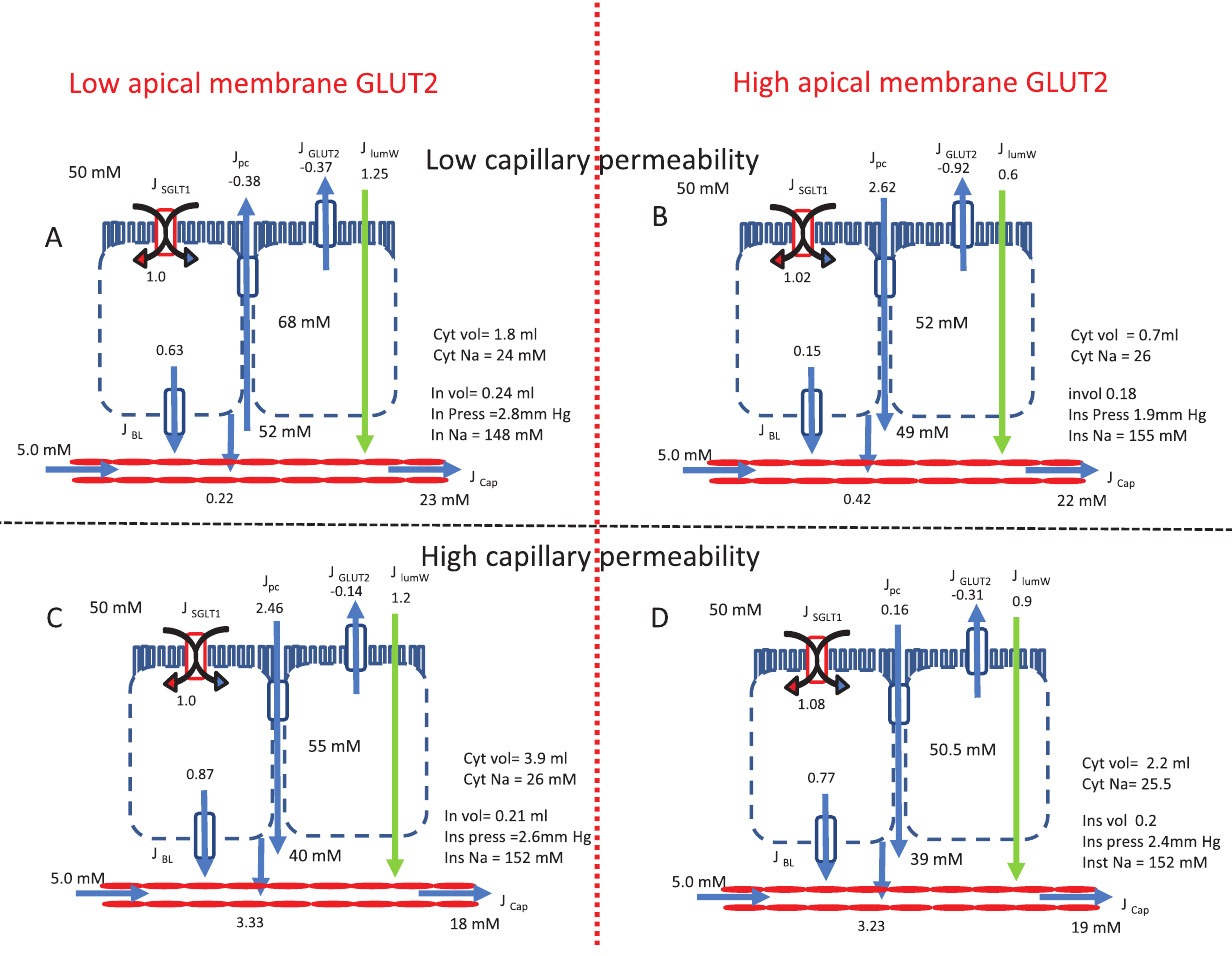
Figure 1. These diagrams show snapshots of the simulated glucose flows from intestinal lumen loaded with 50 mM in 150 mM NaCl to capillaries perfusing the submucosal spaces, whose afferent arterial concentration contains 150 mM NaCl and 5 mM D glucose. The tissue in panel A has low apical GLUT2 and GLUT5 activity and low capillary permeability and perfusion rates (clearance). In panel B the tissue apical membrane GLUT2 activity is increased by 4-fold above that in panel A , capillary perfusion is unchanged. In panel C , the apical GLUT2 activity is the same as in panel A , but capillary clearance is increased by 10-fold. In panel D , the apical GLUT2 is raised, as in panel B and the capillary clearance raised, as in panel C . The rates of glucose uptake are normalized relative to the rate of SGLT1 glucose uptake (panel A ). Altering either GLUT2, or capillary clearance have negligible effects on glucose inflow via SGLT1. However, after raising the apical GLUT2 activity, the steady state glucose concentration within the cytosol decreases from 68 to 52 mM (c.f. Panels A and C ). On raising capillary clearance, the steady state of cytosolic glucose concentration also decreases (c.f. Panel A versus Panel C and Panel B versus Panel D ). Raising capillary glucose clearance increases the rate of glucose inflow from the interstitial to capillary fluid by fourteen fold (c.f. Panel A and C ). These changes are accompanied by decreased interstitial fluid glucose from 52 to 40 mM and reductions in the mean capillary glucose from 23 to 18 mM. Reduced interstitial glucose concentrations reverse the direction of the glucose gradient across the paracellular pathway from -2 to + 10 mM. Thus raising the capillary clearance of glucose, reverses the direction of paracellular glucose flow from (-0.38) to (+2.46) and increases the net glucose inflow across the luminal surface from (0.22 to 3.23). Although raising apical membrane GLUT2 activity by fourfold reduces net glucose influx across the apical border from 0.63 to 0.15, it also indirectly leads to an increase in paracellular glucose flux and thereby causes a slight increase in net glucose flux across the luminal